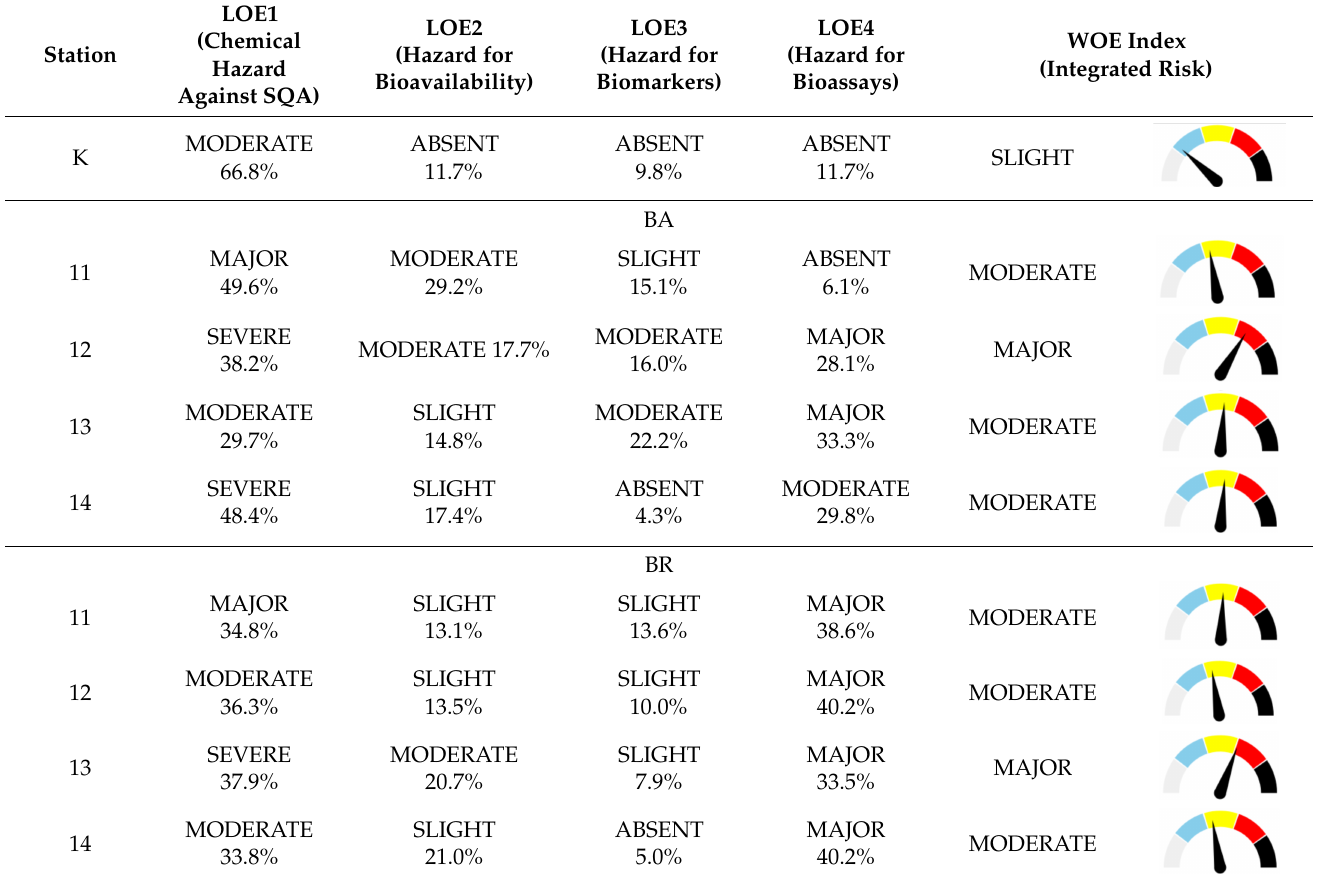
Table 6. Classification of hazard level and WOE index for sediments sampled around offshore platforms (BA and BR) and control area (K), with Chemical hazard (LOE1) estimated using EQS values. The contribution to the WOE (as %) is reported for each